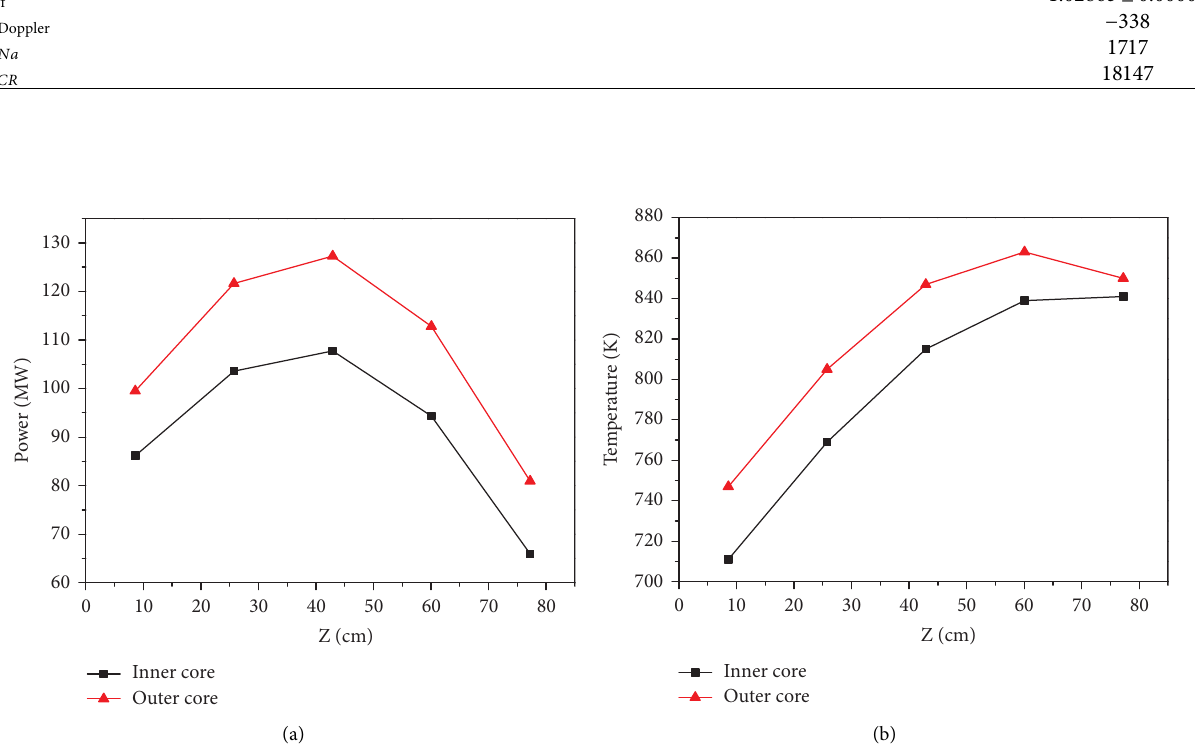
Figure 15: Axial distribution of power and average fuel temperature. (a) Power. (b) Average fuel